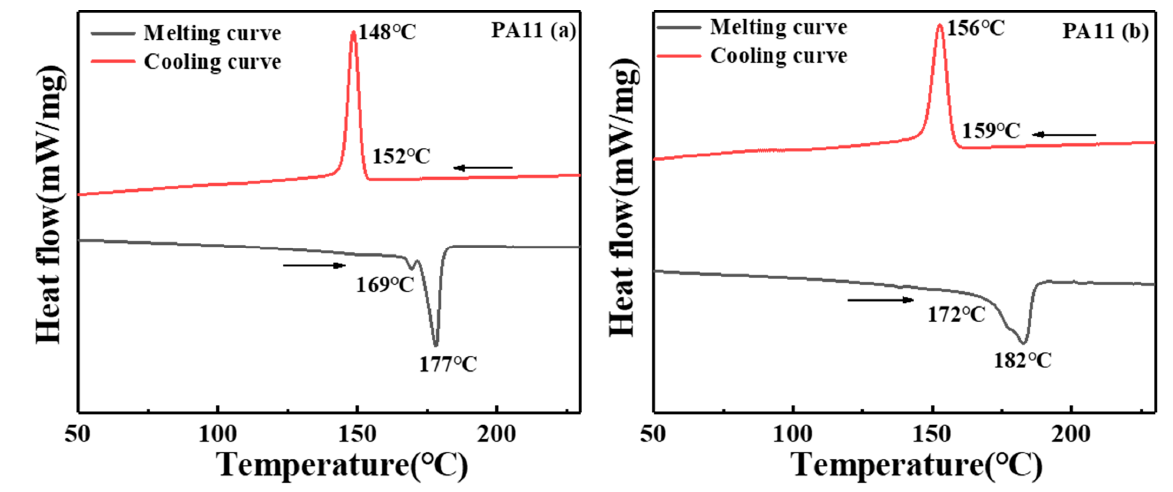
Figure 1. DSC curves of two PA11 materials.